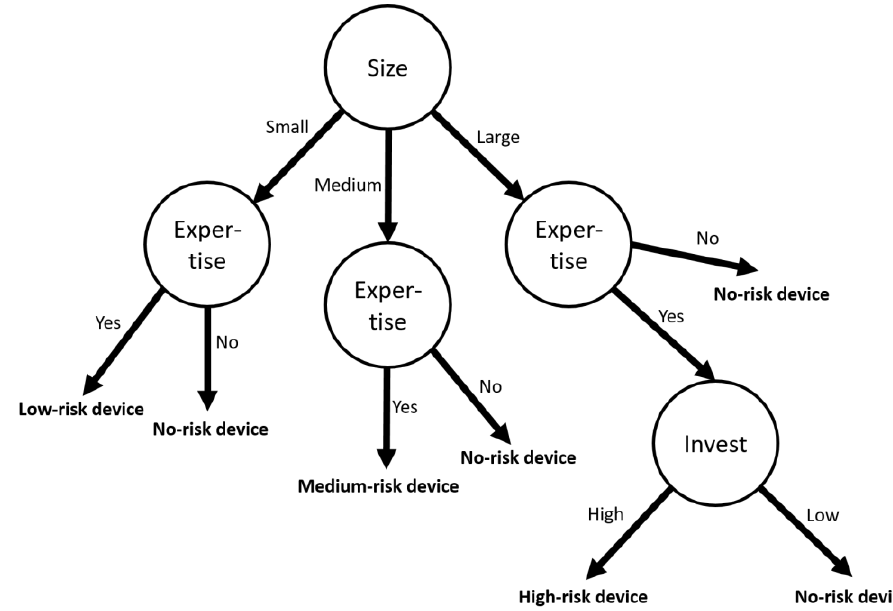
Figure 2. Decision tree generated for the device risk problem presented in Table 1 for the AQDT-1, AQDT-2 and ID3 algorithms [20]. It consists of five attribute nodes and seven leaf